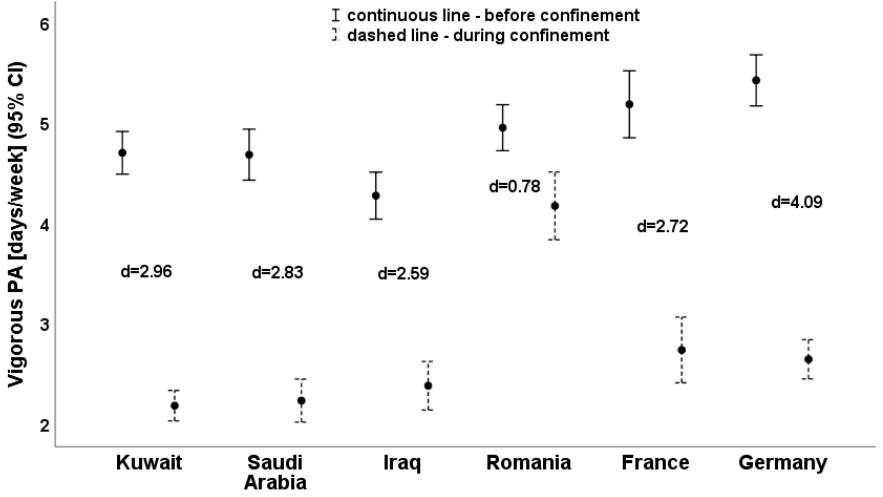
Figure 3. Vigorous PA (days per week) depending on the five countries with the largest sample size.